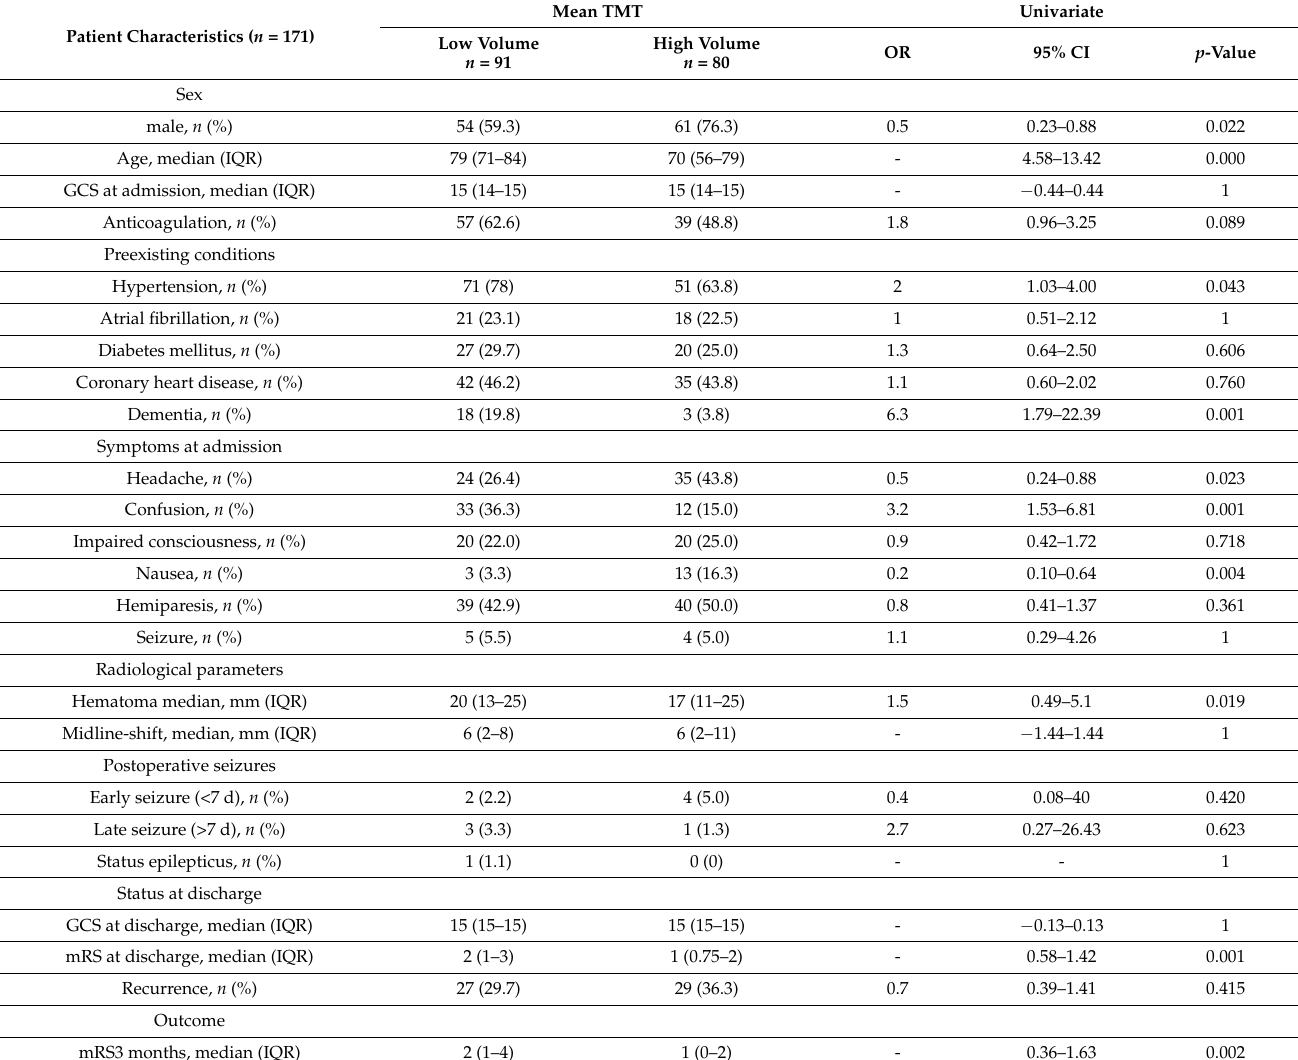
Table 2. Univariate analysis of juxtaposed characteristics according to TMT volume in CSDH. Abbre- viations: OR: odds ratio, IQR: interquartile range, GCS: Glasgow Coma Scale, CRP: C-reactive